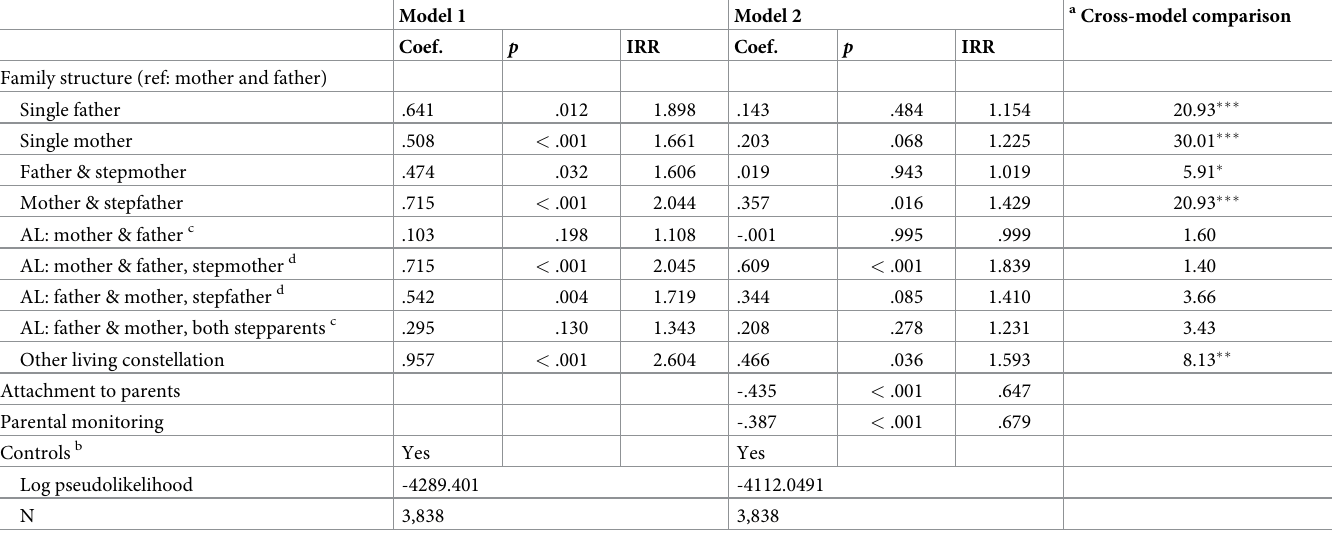
Table 3. Relationship between family structure and delinquent behaviour (variety scale). Negative binomial